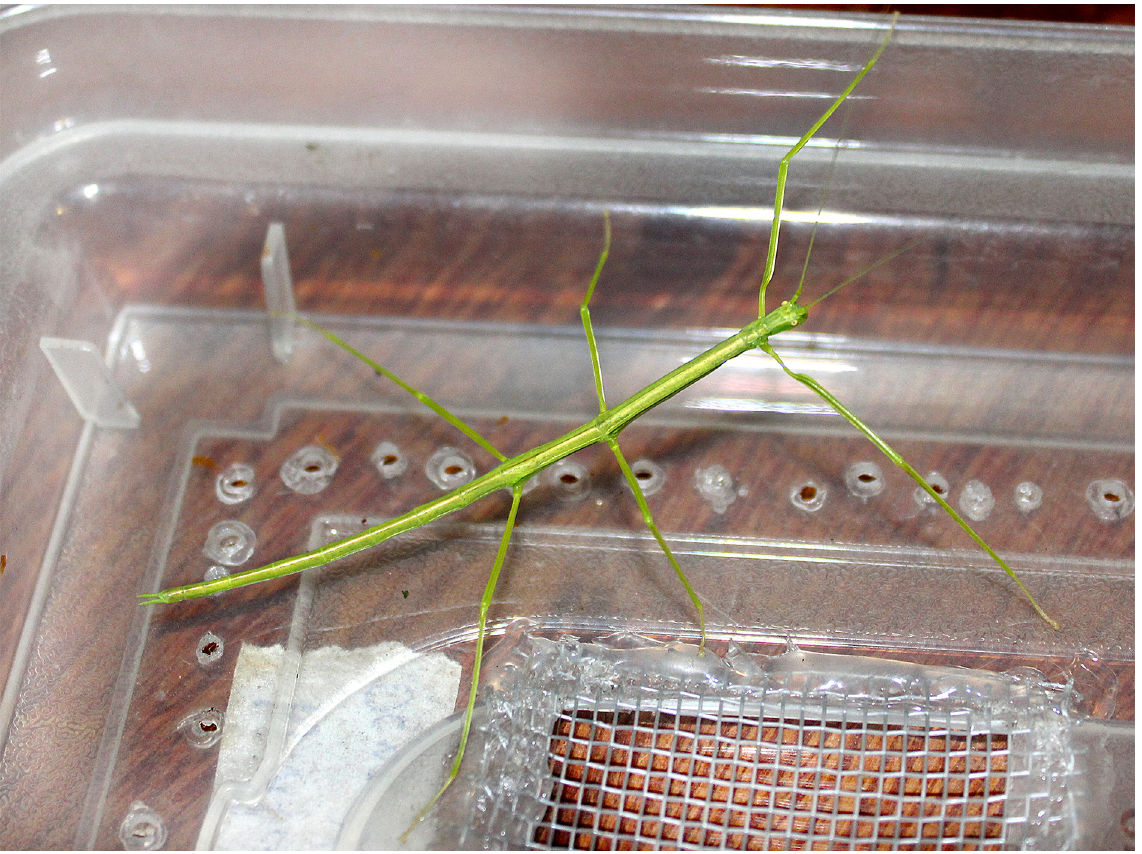
Fig. 20. Arumatia crassicercata Ghirotto, Crispino & Engelking gen. et sp. nov., live habitus of adult ♀ from Chapada dos Veadeiros, Goiás,